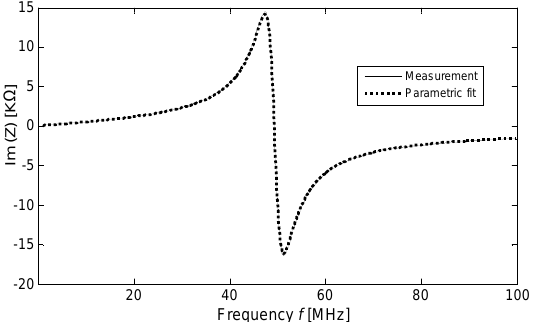
Figure 6. Measured impedance imaginary part and analytical fit for a micro coil with 33 turns and resonance frequency of 50.98MHz.